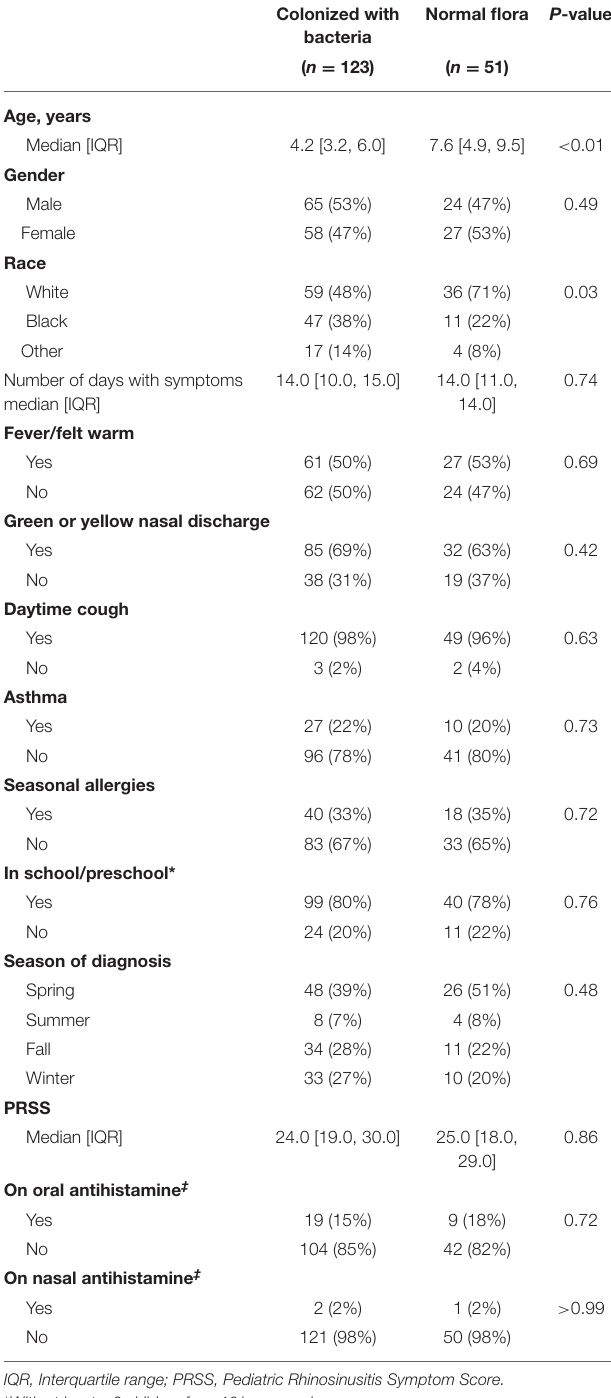
TABLE 1 | Demographics and clinical characteristics of children with acute